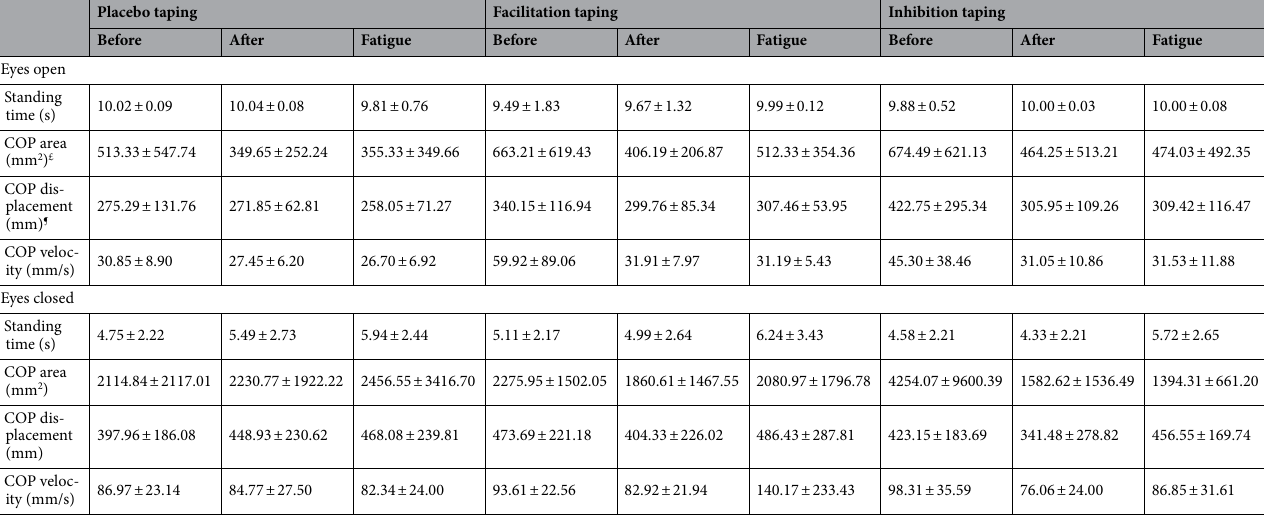
Table 3. The balance data of three taping groups on soft-mat with eyes open and eyes closed condition. £ Significant difference between before and after taping, and between before and after fatigue exercise for three group. ¶ Significant difference between before and after fatigue exercise for three group.